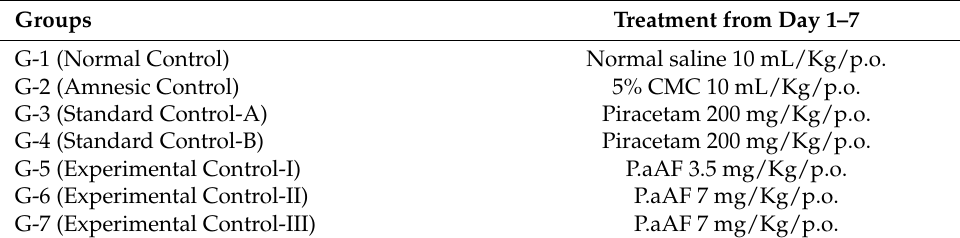
Table 7. Study design for behavioral and biochemical studies. Groups